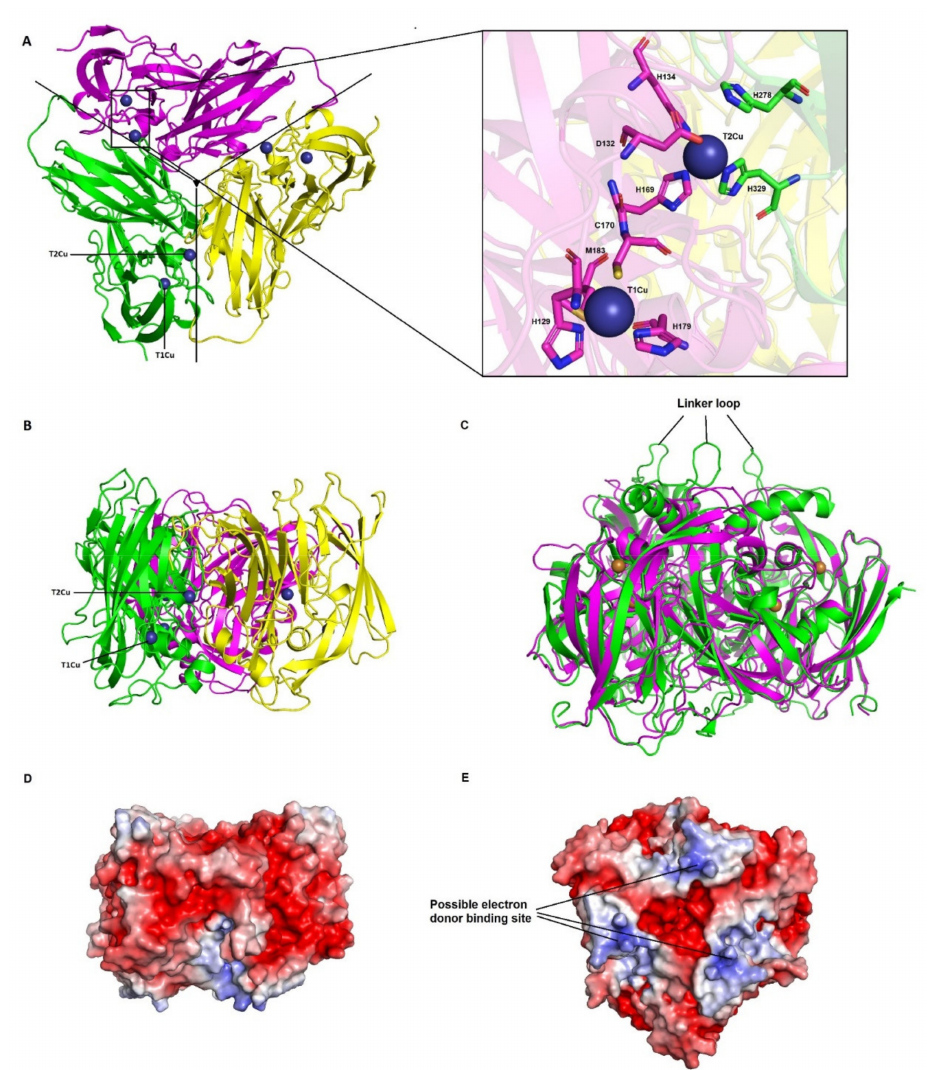
Figure 6. Homology model and electrostatic surface potential of Haloferax mediterranei NirK ( A ) Struc- tural model of Haloferax mediterranei NirK in which the three subunits (in cartoon) are coloured in yellow, green, and magenta ( left ). The interface between monomers is indicated by a black continu- ous line. Cu atoms are represented as dark blue spheres and named T1Cu and T2Cu whereas amino acids involved in Cu coordination are shown in sticks ( right ). ( B ) 90 ◦ rotation view from A. ( C ) Su- perimposed structures of NirKs of Alcaligenes xilosoxidans (green; Uniprot: O68601) and Haloferax mediterranei (magenta; Protein NCBI ID: WP_004059594.1) highlighting linker loops. ( D , E ) Electro- static surface potential of Haloferax mediterranei NirK trimer. D is in the same orientation as B whereas E is rotated 180 ◦ in vertical plane from A and 90 ◦ in horizontal plane from D. The electrostatic potential is represented between +5 and -5 kT/e